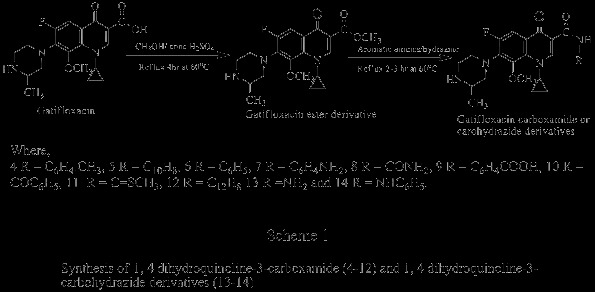
Synthesis of 1, 4 dihydroquinoline-3-carboxamide (4–12) and 1, 4 dihydroquinoline-3-carbohydrazide derivatives (13–14).